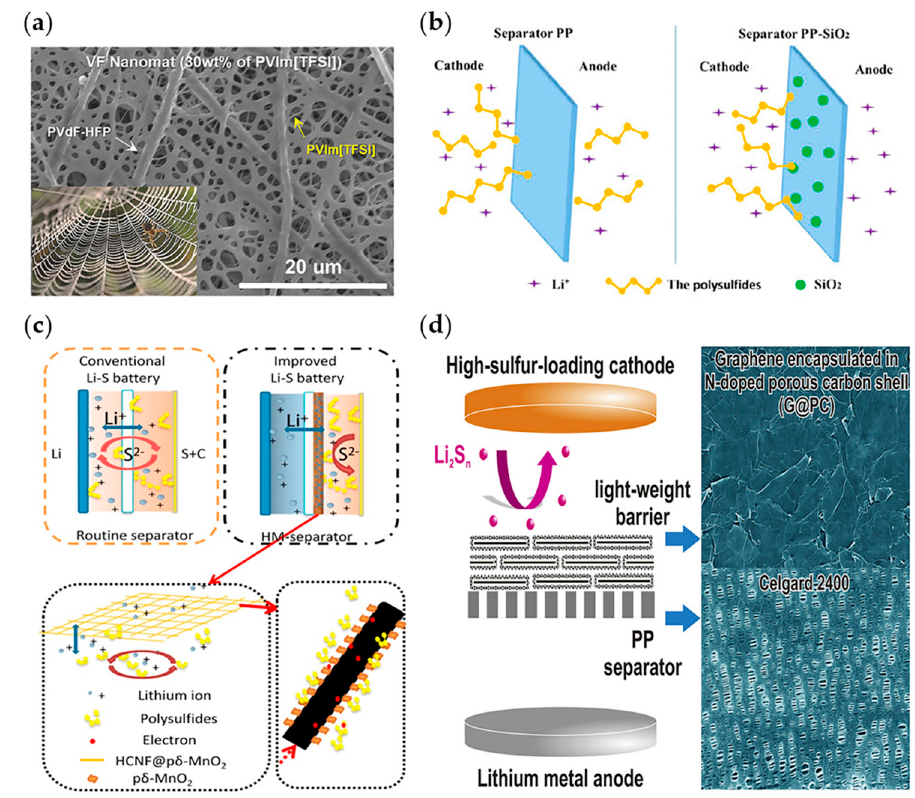
Figure 10. ( a ) SEM image of the VF nanomat (30 wt.% of PVIm[TFSI]), well-developed porous